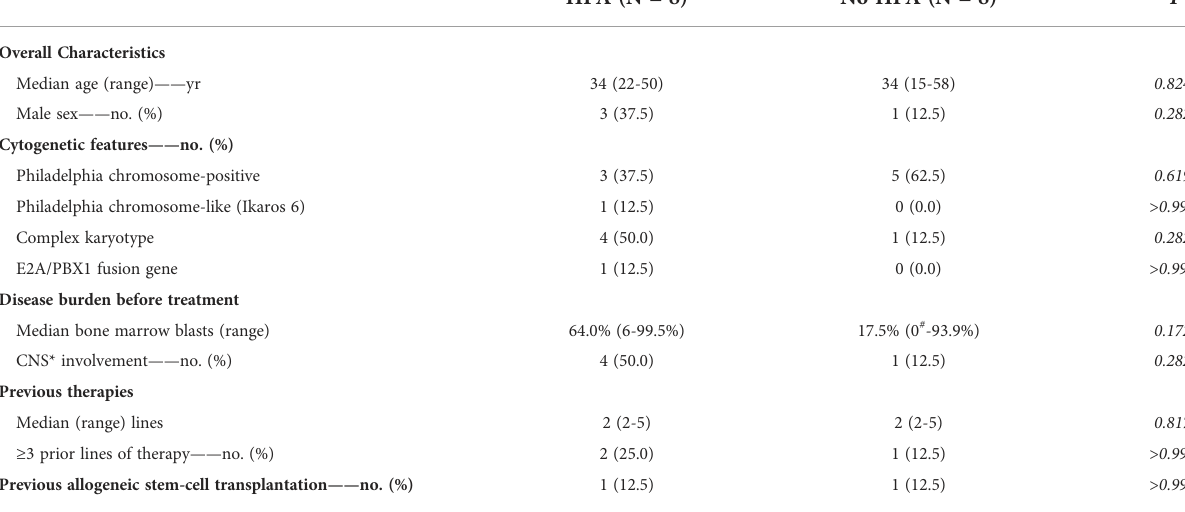
TABLE 2 Clinical characteristics of ccute lymphoblastic leukemia patients.